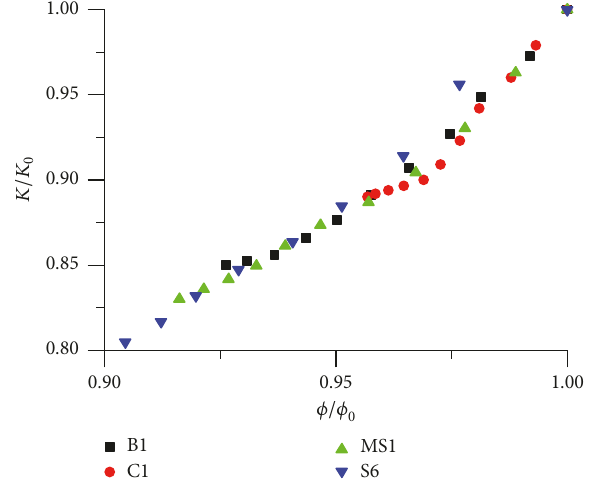
Figure 5: Permeability variation versus porosity